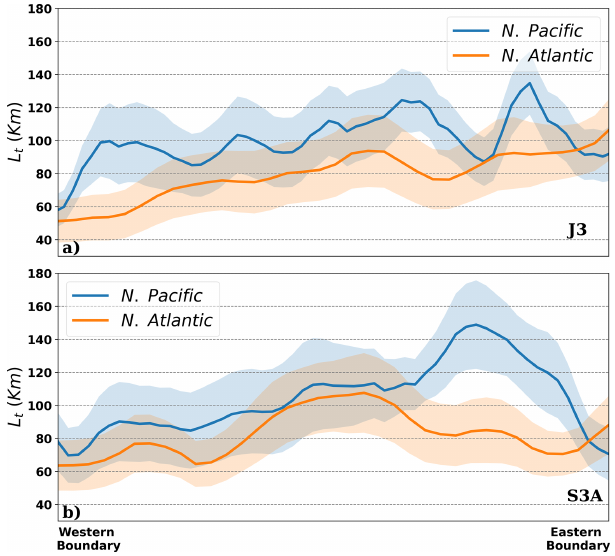
Figure 7. Meridional average of the intercept wavelength presented in Fig. 4 over the North Pacific (130 ◦ E, 30 ◦ N–240 ◦ E, 50 ◦ N) and North Atlantic (280 ◦ E, 30 ◦ N–350 ◦ E, 50 ◦ N) for Jason-3 (a) and Sentinel-3A (b) . The envelope around the averages indicates the 1 σ